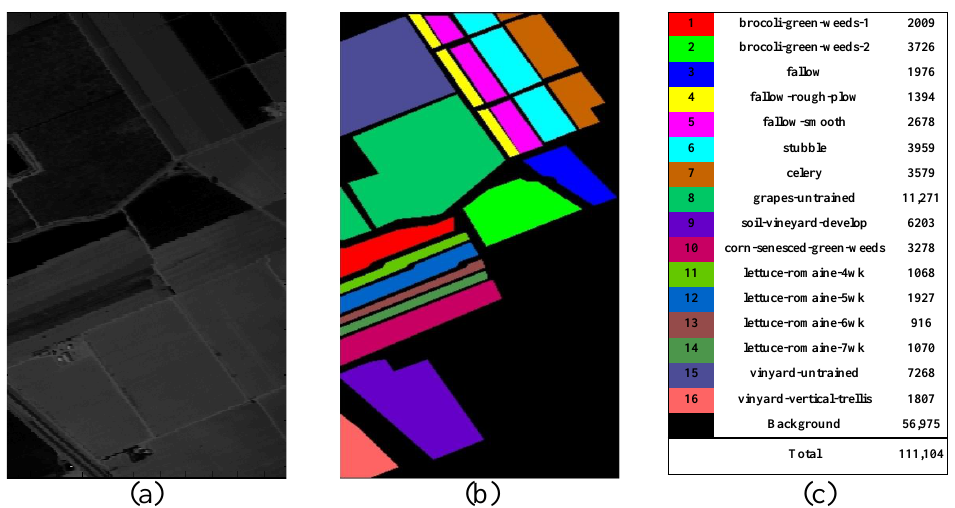
Figure 9. Salinas imagery: ( a ) color composite with RGB, ( b ) ground truth, and ( c ) class names with available